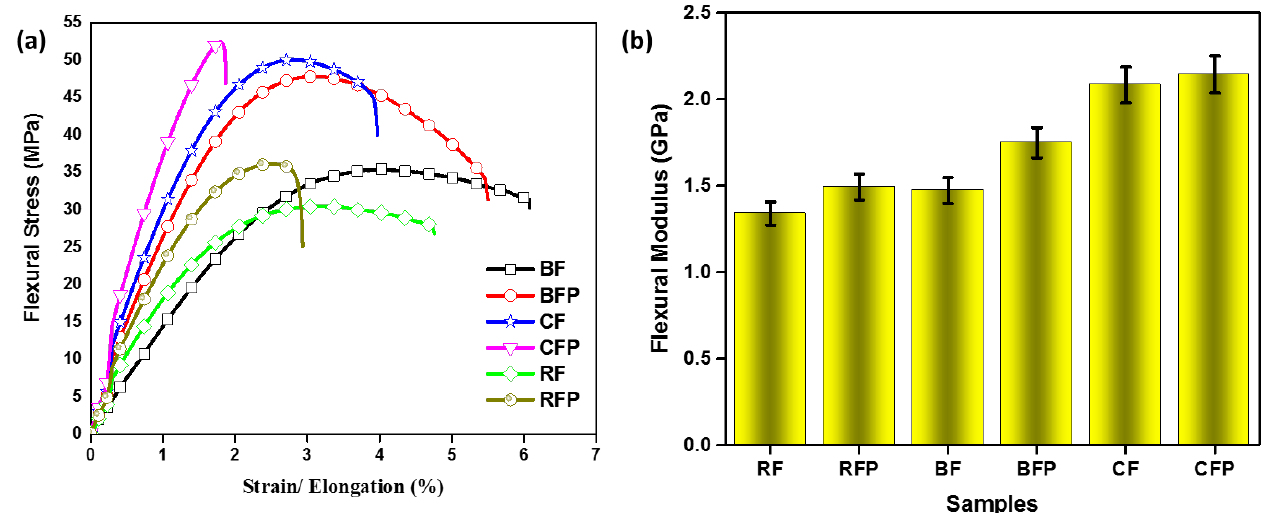
Figure 3. The three-point bending analysis of samples is approximated from ( a ) stress–strain behavior and ( b ) flexural modulus.